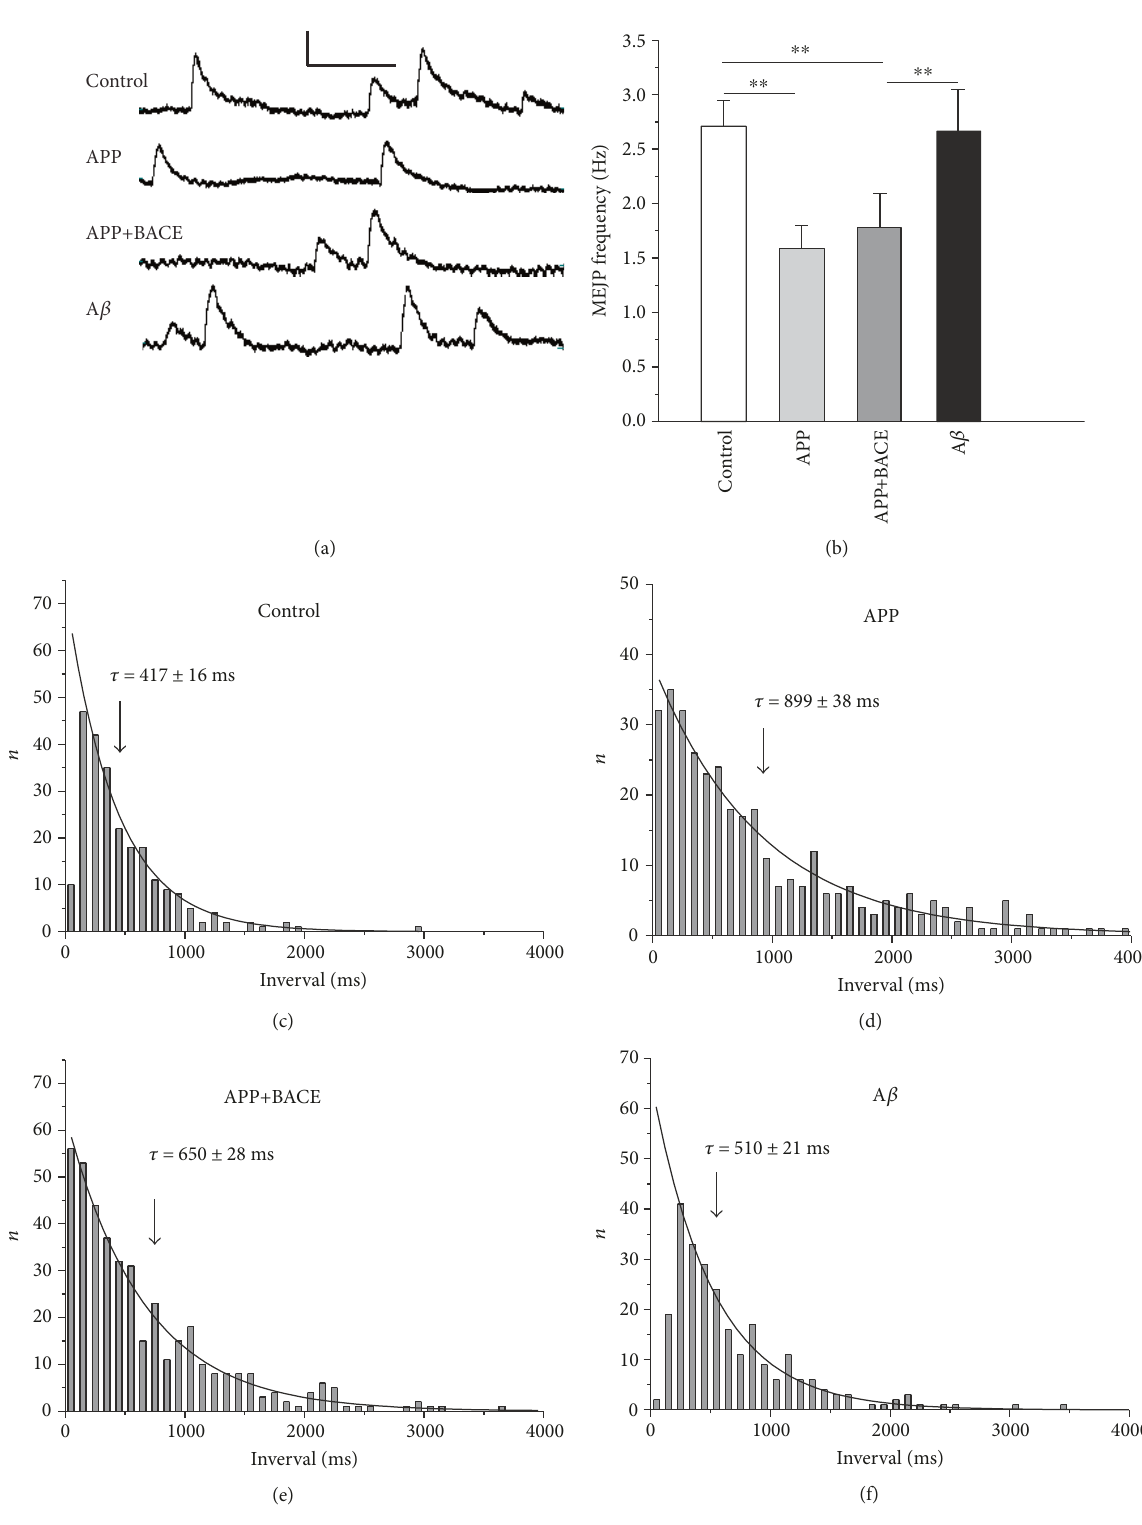
Figure 5: mEJPs recoded at muscle fi ber 6 and 7 neuromuscular junctions from transgenic Drosophila melanogaster larvae. (a) Sample of original mEJP traces from representative individual experiments. Calibration: vertical, 1 mV; horizontal, 200ms. (b) Average mEJPs frequency. (c – f) Distribution of inter-event intervals between mEJPs recorded in representative individual experiments. (c) Control, (d) APP, (e) APP+BACE, and (f) А β lines. Curve fi tting assuming a monoexponential decay con fi rming the random nature of spontaneous neurotransmitter release in all Drosophila lines. τ — the time constants, obtained from corresponding monoexponential fi tting. Data are presented as mean ± SEM. ∗∗ P < 0 01 compare to corresponding